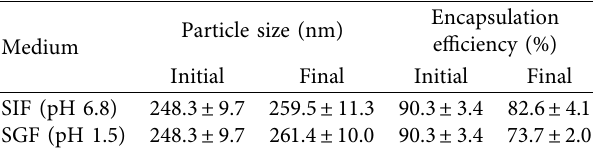
Table 1: The stability study of Ber-loaded SLN-chitosan nano- particles at SIF and